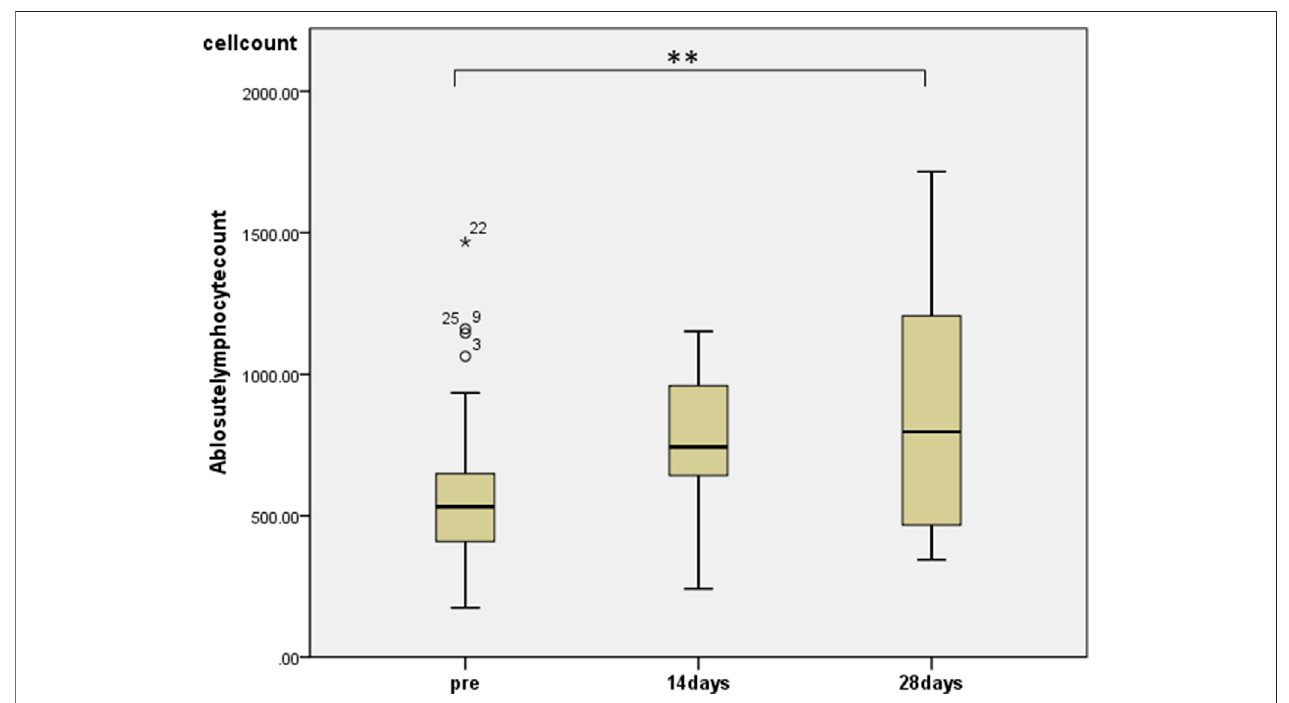
FIGURE1| TheeffectsofHETandKKTonwholebloodcellcounts.HETandKKTadministrationresultedinasigni fi cantincreaseintheabsolutelymphocytecount in the blood.